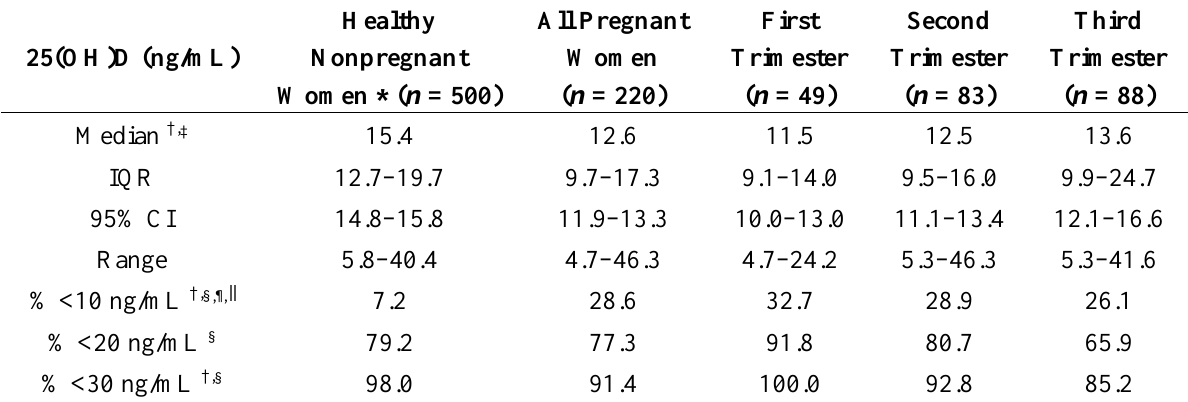
Table 2. The 25-hydroxyvitamin D—25(OH)D—concentrations in 220 pregnant Korean women across three trimesters and in 500 healthy nonpregnant